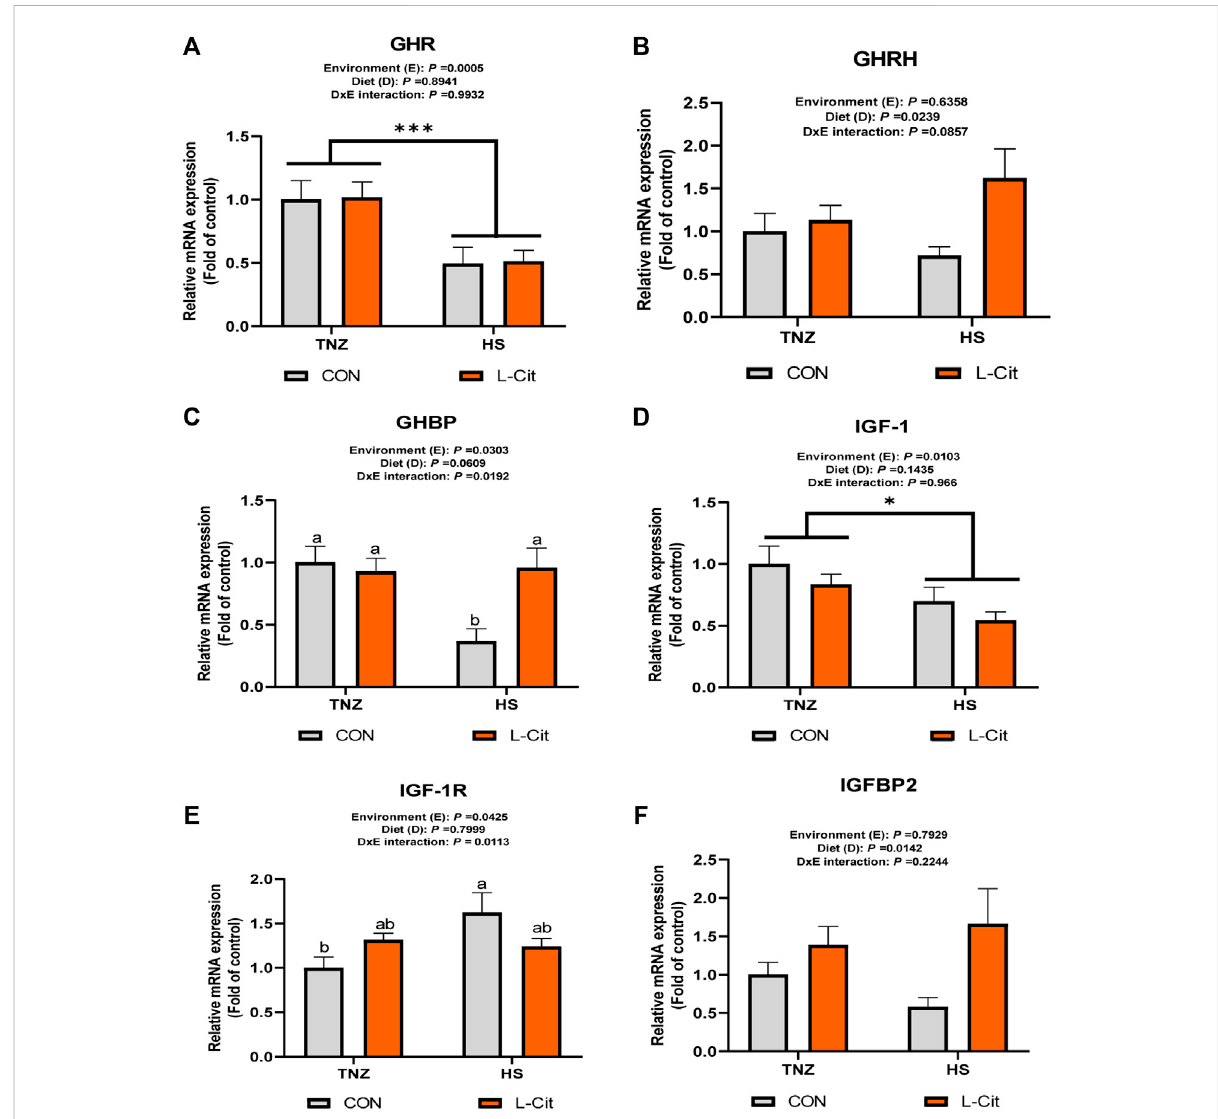
FIGURE 1 Effects ofheatstressand l-citrullinesupplementationon somatotropic axisgeneinthehypothalamus ofbroilers (A )Growth hormonereceptor (GHR) (B) Growth hormone releasing hormone (GHRH) (C) Growth hormone binding protein (GHBP) (D) Insulin-like growth factor-1 (IGF-1) (E) Insulin-likegrowthfactor-1receptor(IGF-1R) (F) Insulin-likegrowthfactor-1bindingprotein2(IGFBP2).Datawerepresentedasmean±SEM( n =8). Means with different alphabetical superscripts indicate signi fi cant differences in environment × diet interaction at p < 0.05; Asterisk indicate signi fi cant effect of environment at * p < 0.05; *** p <